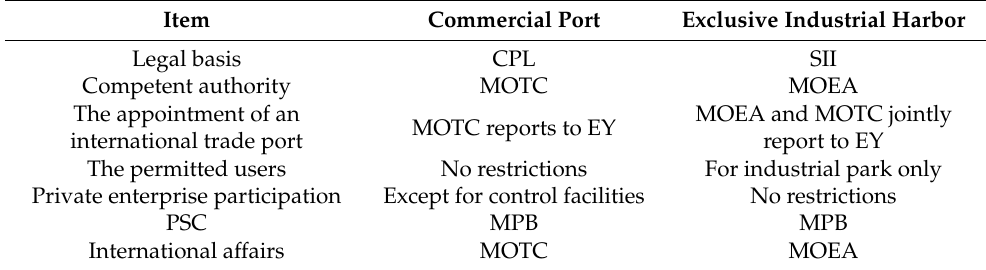
Table 2. Summary of differences between commercial ports and exclusive industrial